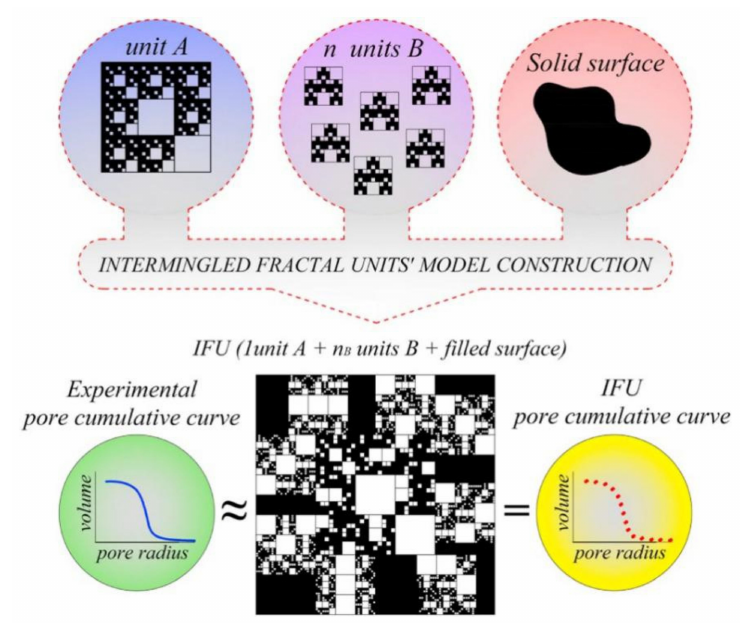
Figure 4. IFU procedure to simulate pore accumulation curve.